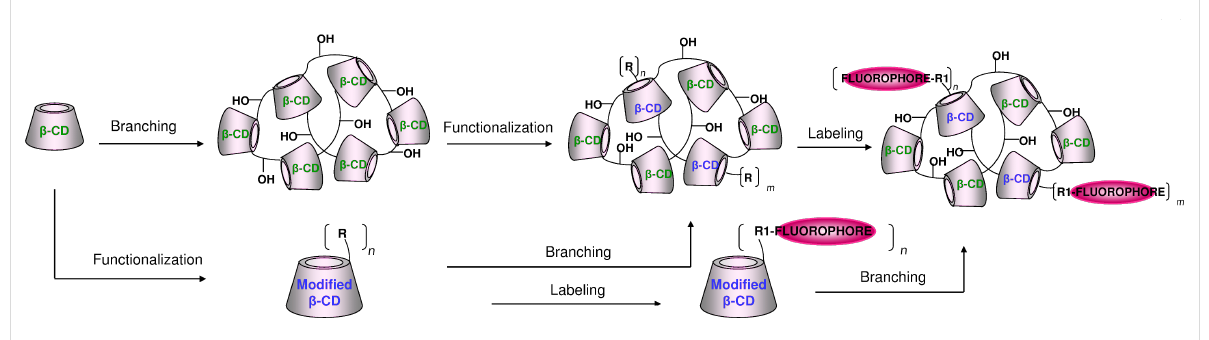
the anchoring group for the fluorescent labeling into the CD-monomer occurs before the branching of the modified